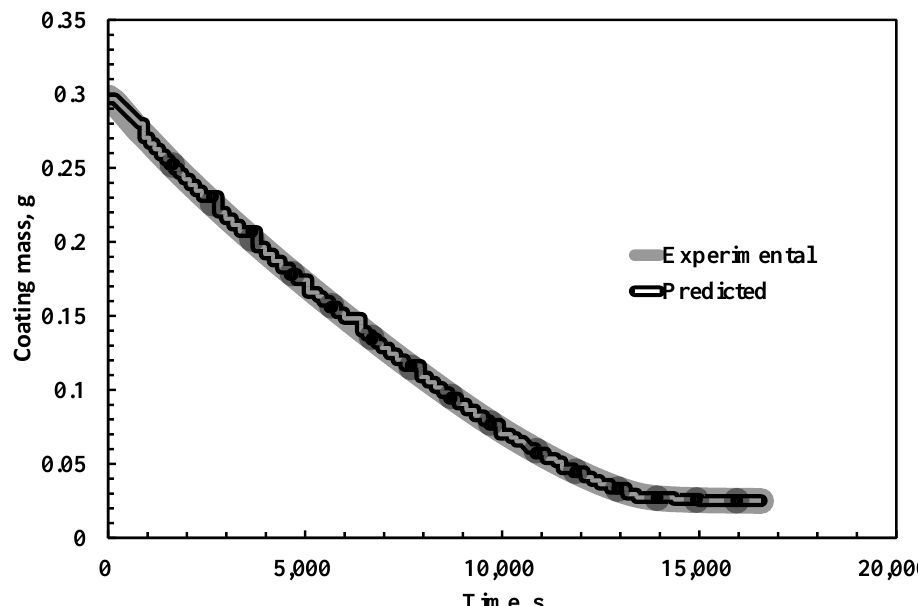
Figure 5. Comparison of model prediction with the experimental values for coating having 1999 micron initial coating thickness having poly(styrene), p -xylene, and TPP, 5.03%, 93.95%, and 1.02% respectively.